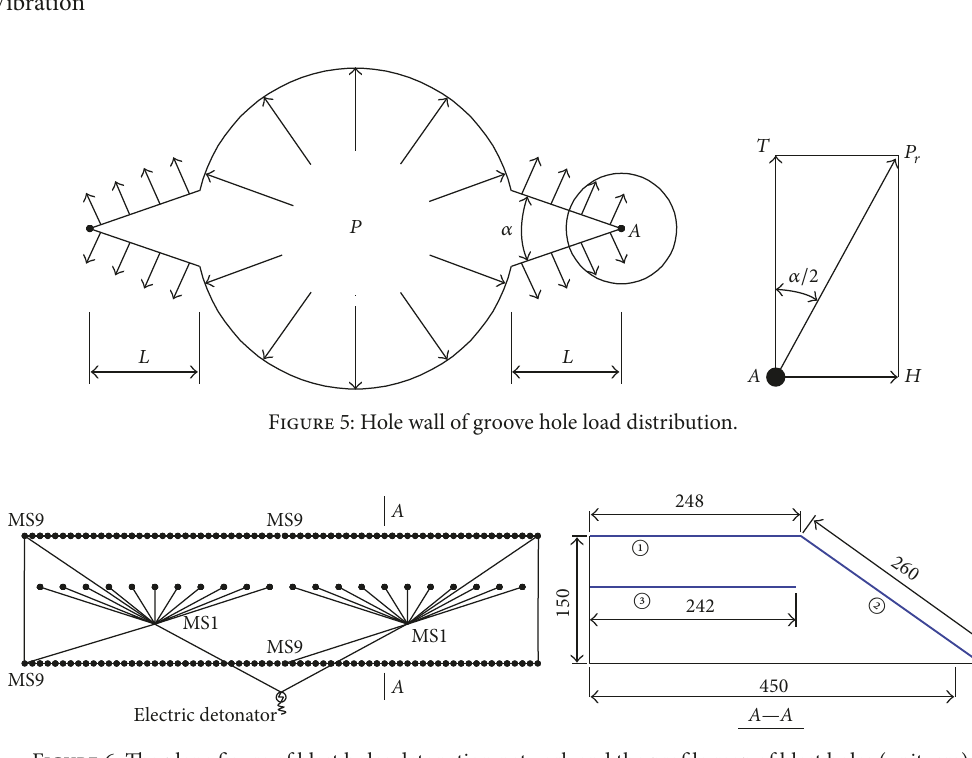
Figure 6: The plane figure of blast holes detonation network and the profile map of blast holes (unit: cm).